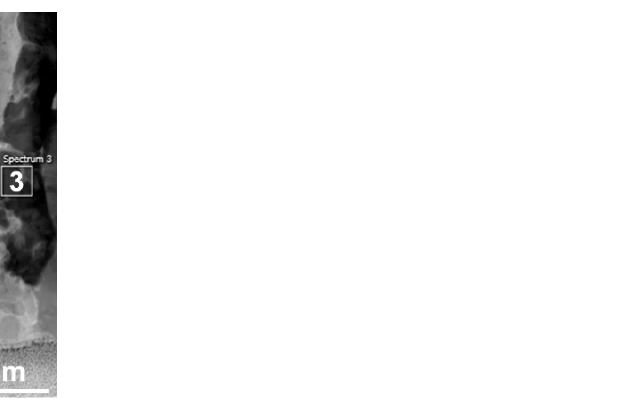
Figure 6. TEM scan (bright field) of the detailed view of the cracked location, with depicted areas of local EDS scanning. Table 2. Chemical compositions of the scanned areas depicted in Figure 6.